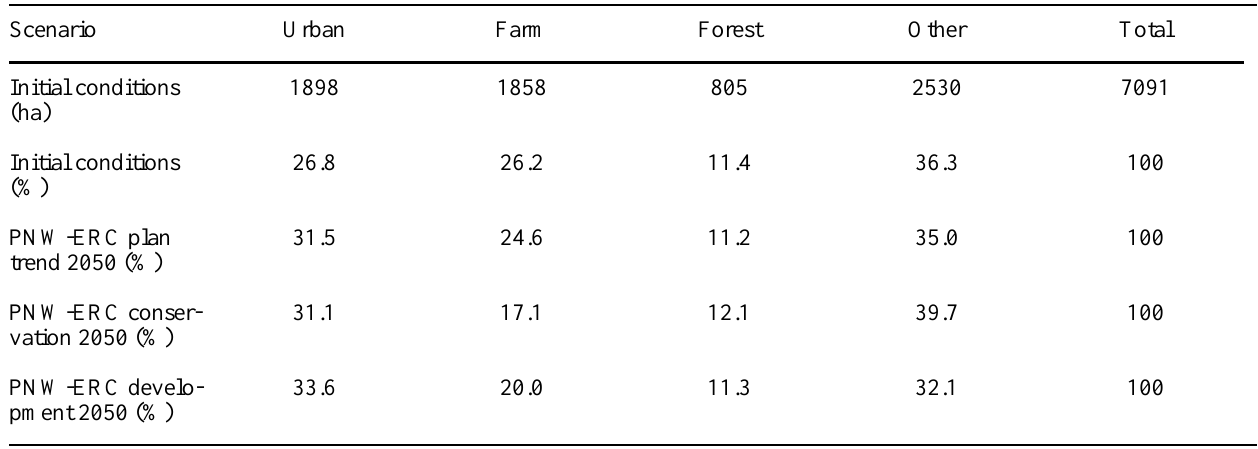
Table 5 . PNW-ERC distribution of land uses between initial conditions and percent land use in year 50 for plan trend, conservation, and development scenarios. Urban Farm Forest Other